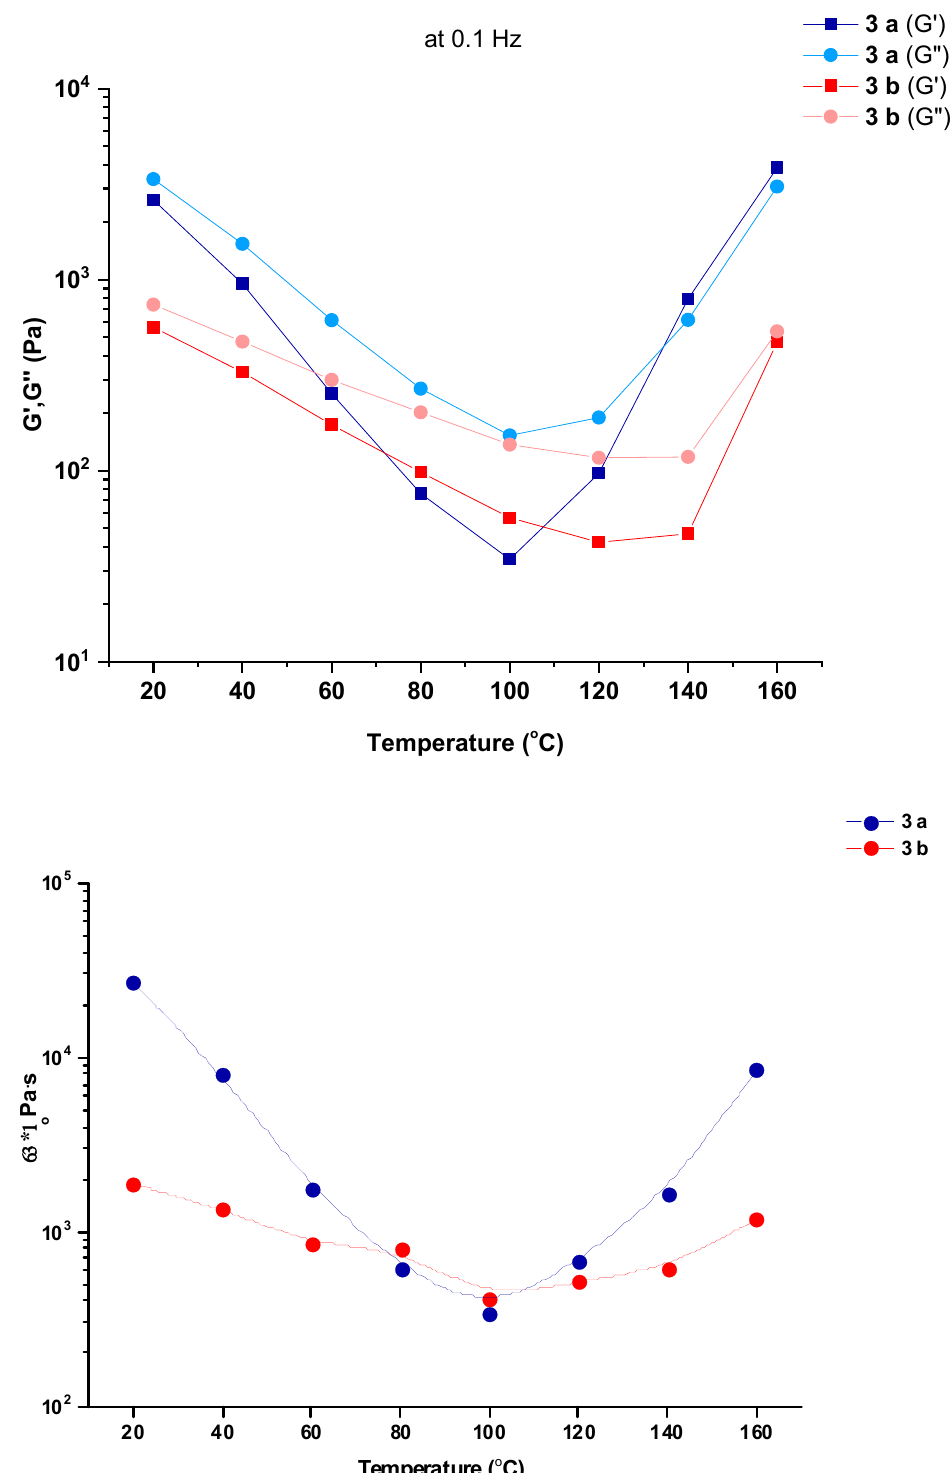
Figure 18. Frequency dependences of G ′ ,G ″ ( top ) and [ η *] 0 ( bottom ) for polymers 3 a , b at different temperatures.